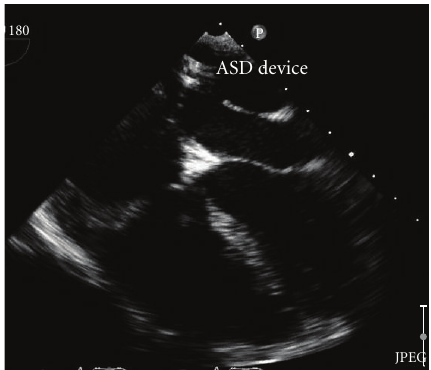
were adequate rims (length of rims more than 10